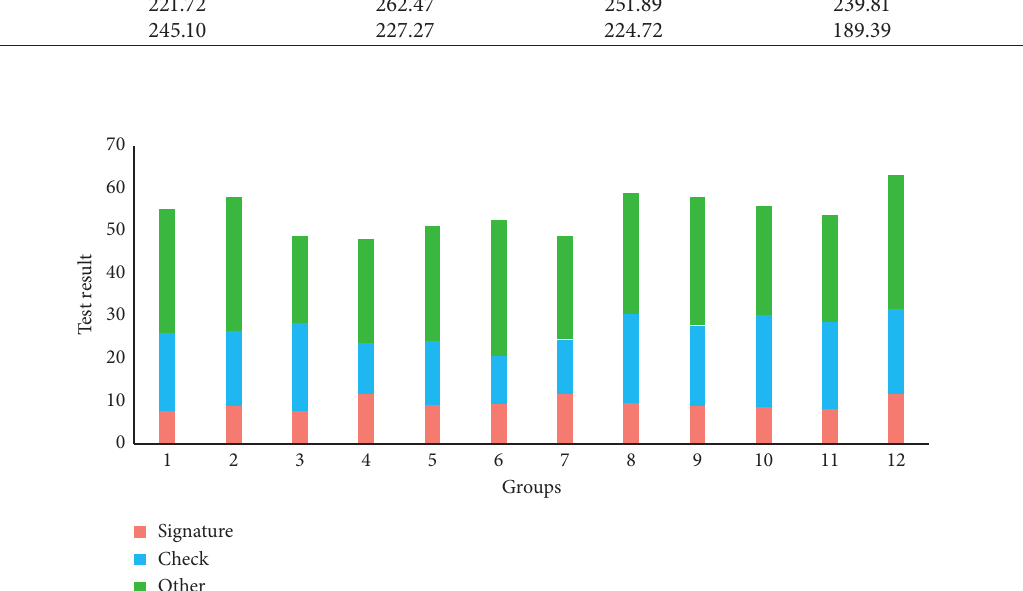
Figure 8: Algorithm performance analysis at different matrix sizes.